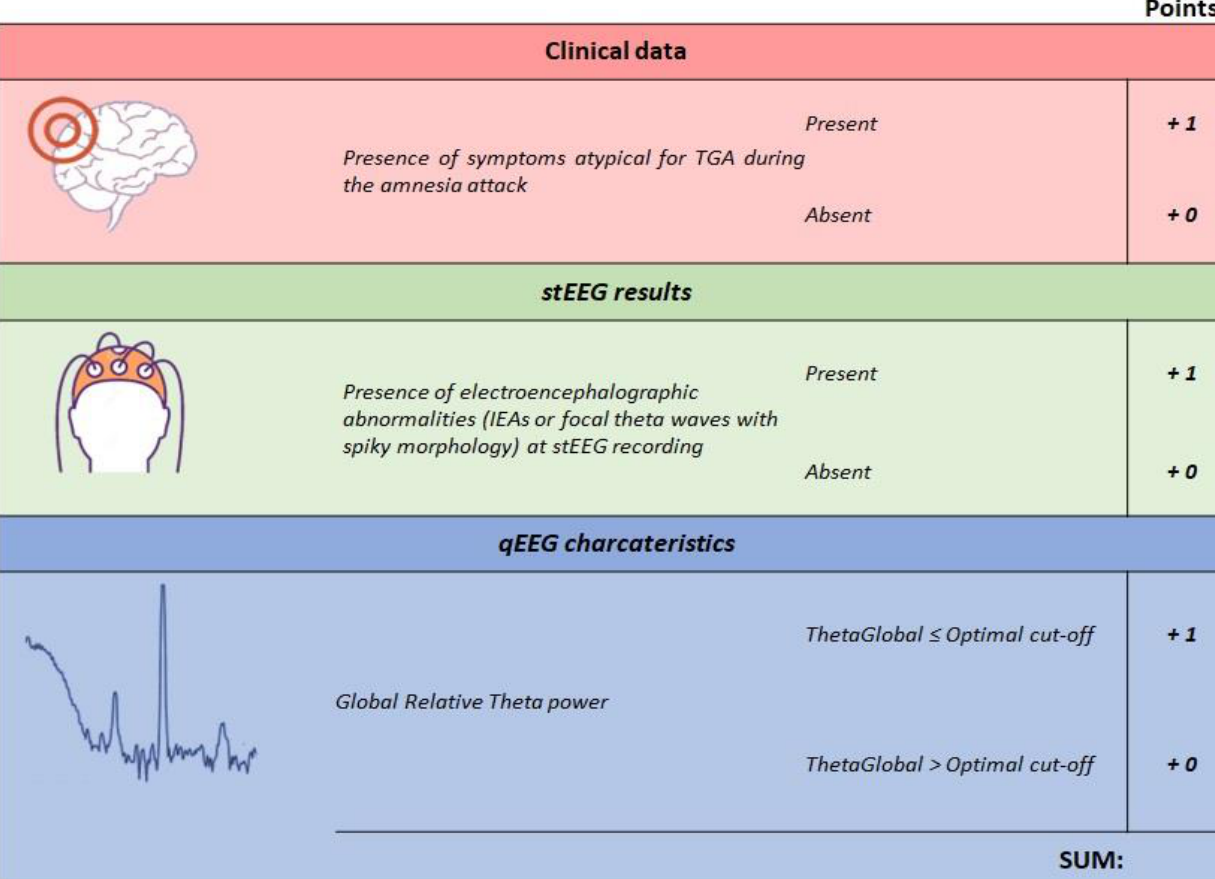
Figure 4. Construction of EPIMANE score. EPIAMNE score (EPIlepsy AMNEsia Score), IEA (interictal epileptic anomalies), qEEG (quantitative EEG), stEEG (standard EEG), TGA (transient global